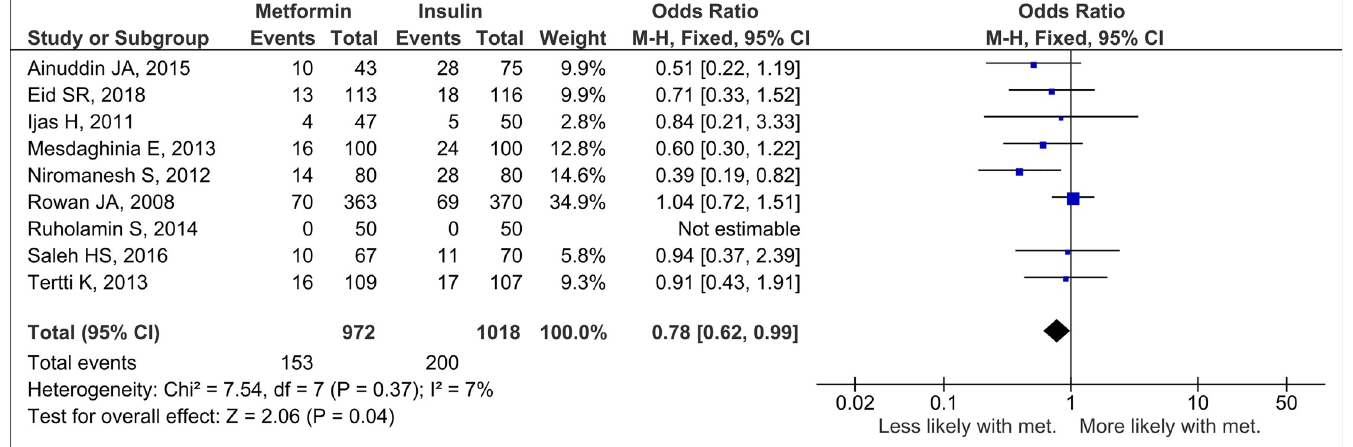
Fig 4. Large for gestational age. Expressed as OR (fixed effects model) and 95% CI. M-H, odds ratio; met., metformin.